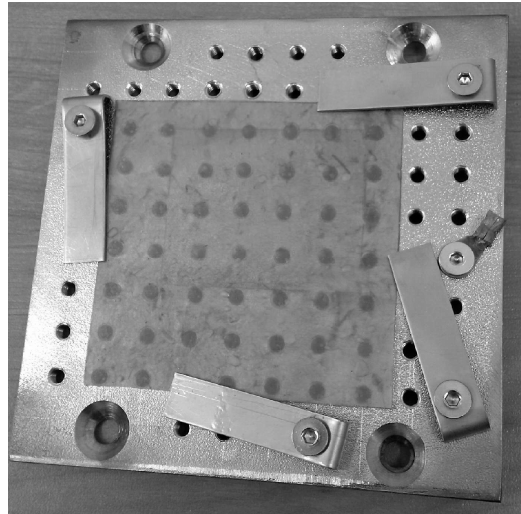
Figure 1. The implanted cellulose in the steel sample